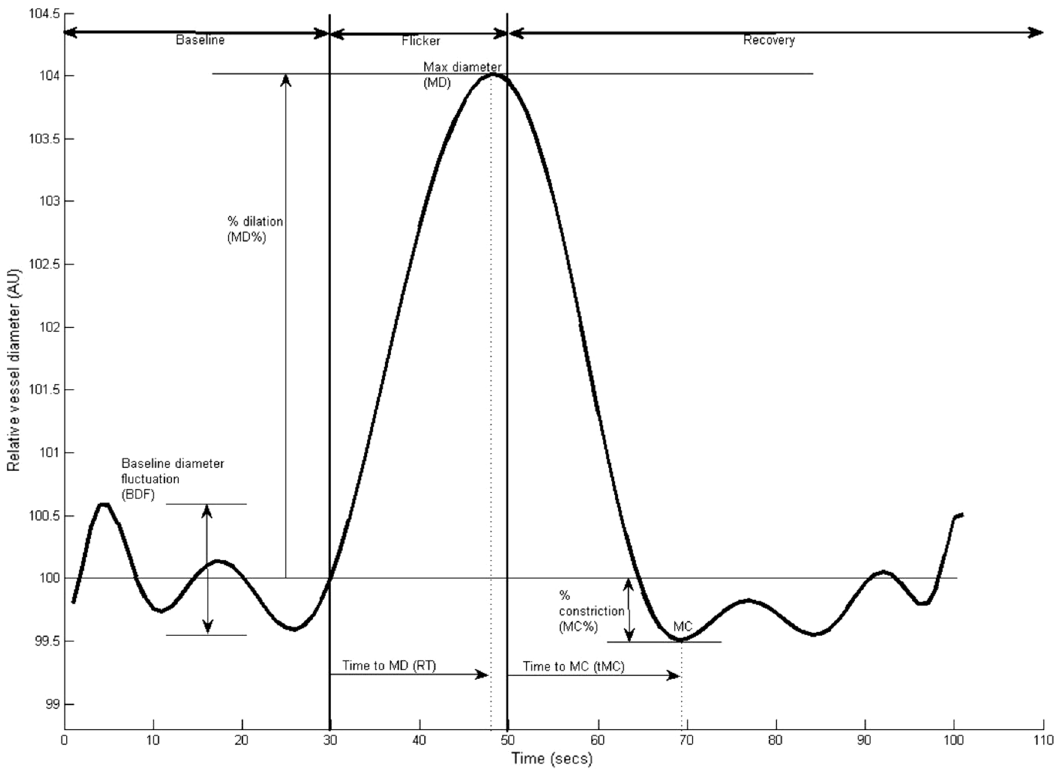
Figure 1. Graphical presentation of the dynamic vessel response profile displaying the parameters calculated and used in analysis. (DA) calculated as (MD-MC). (MD%) calculated as the percent increase from baseline to MD. (MC%) calculated as the percent constriction below baseline following